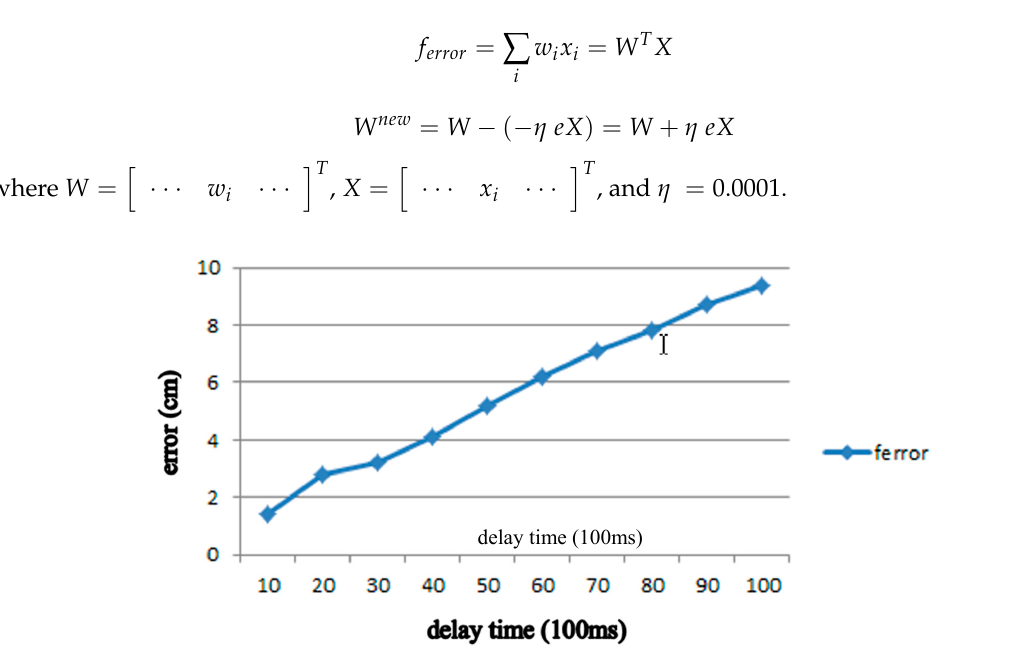
Table 4. Comparison of travel distance after compensation. Travel Time (s)